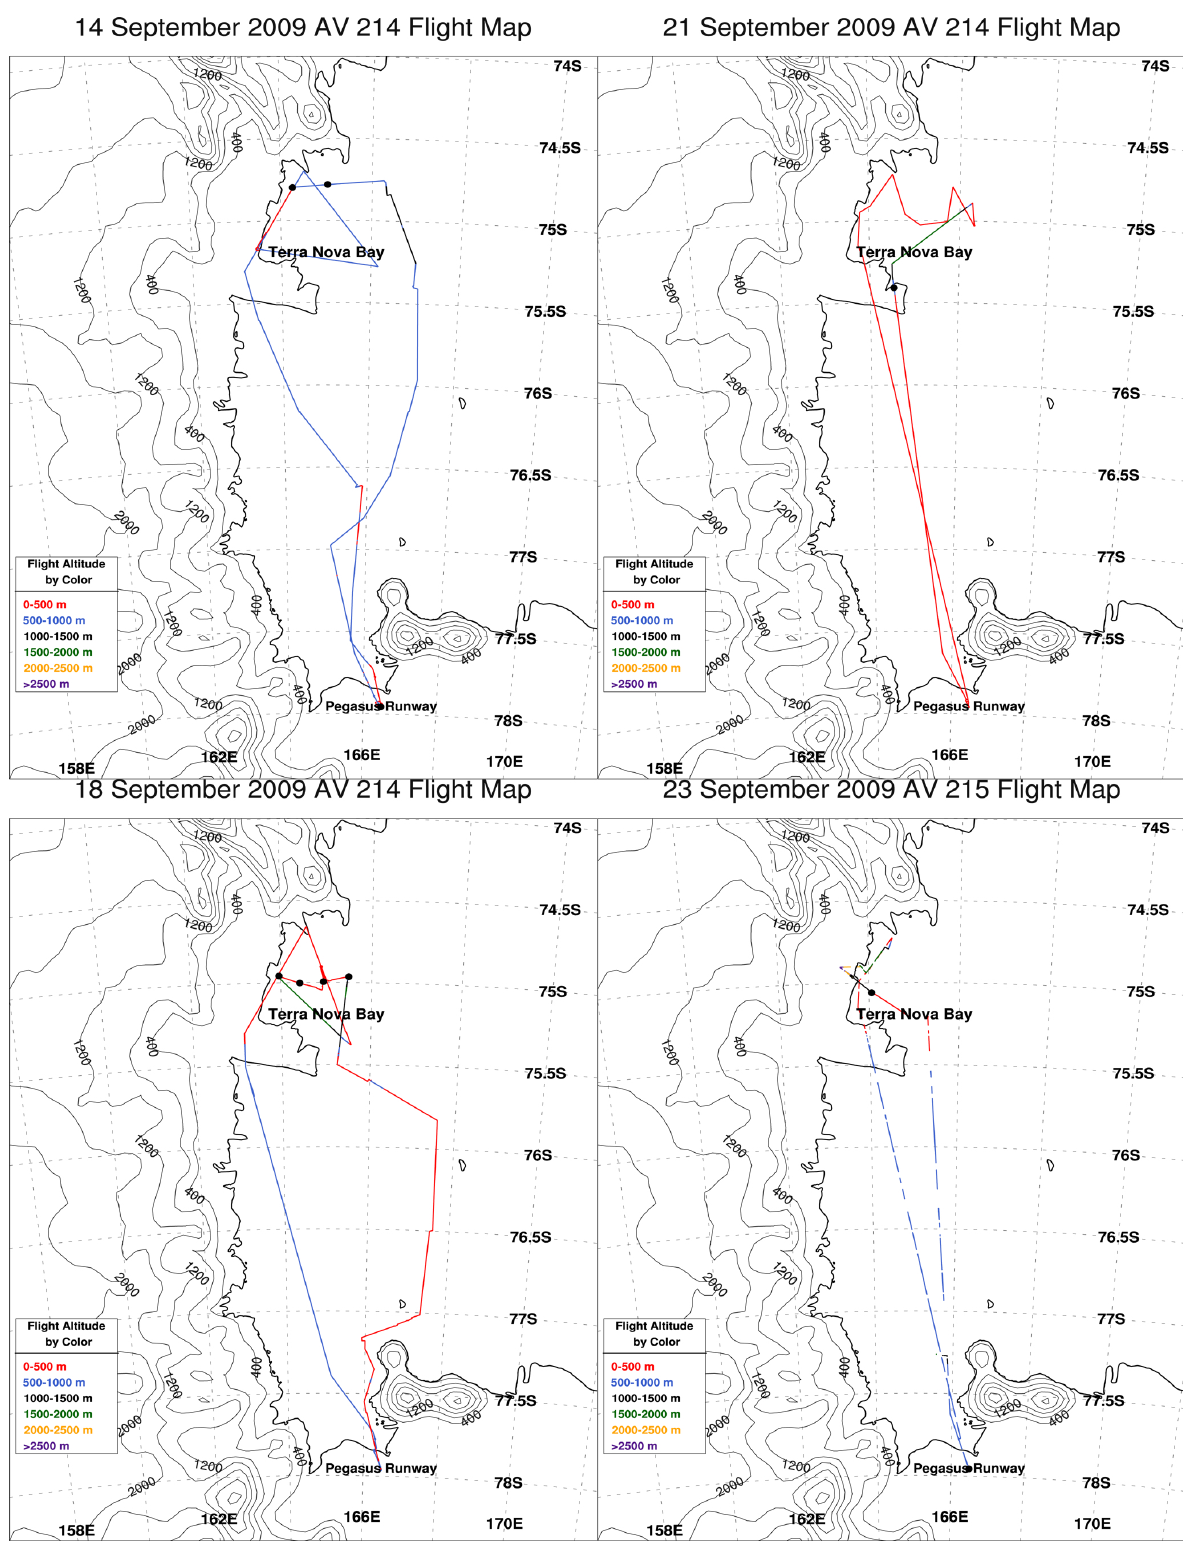
Figure 3. Flight path for the eight science flights from Pegasus Runway to Terra Nova Bay. Gaps in the flight path indicate a lack of data. Profile locations are marked with a black dot. Flight altitude is indicated by the color scale shown in each panel. Topographical contours are in